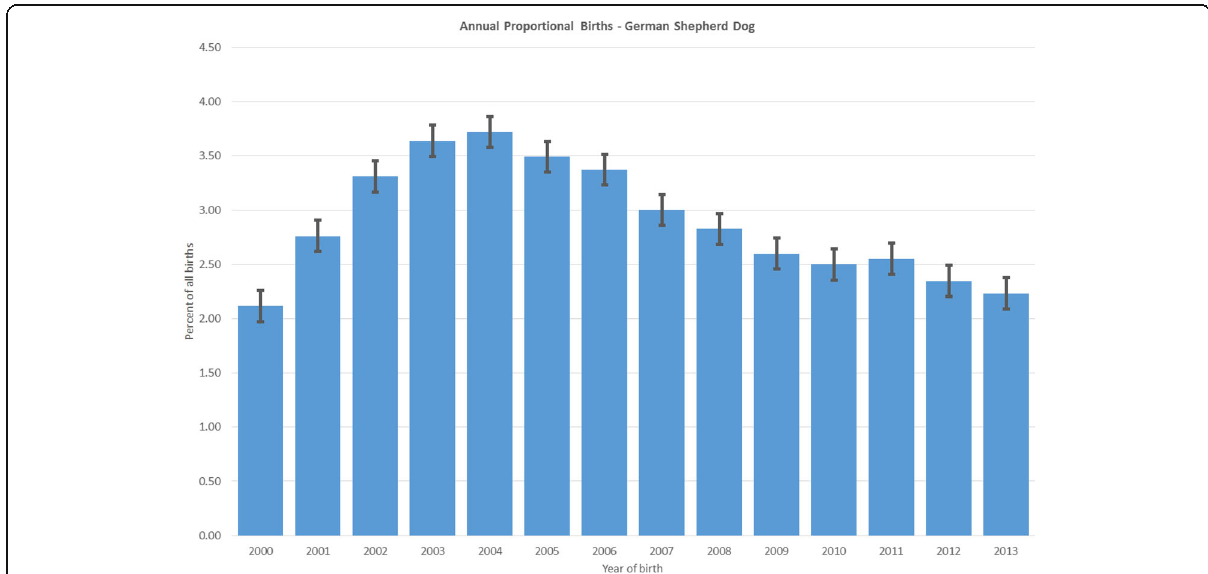
Fig. 2 Annual proportional birth rates (2000 – 2013) for German Shepherd Dogs among all dogs ( n = 455,557) under primary veterinary care during 2013 at clinics in the UK participating in the VetCompass TM Programme. Standard error bars are shown for each